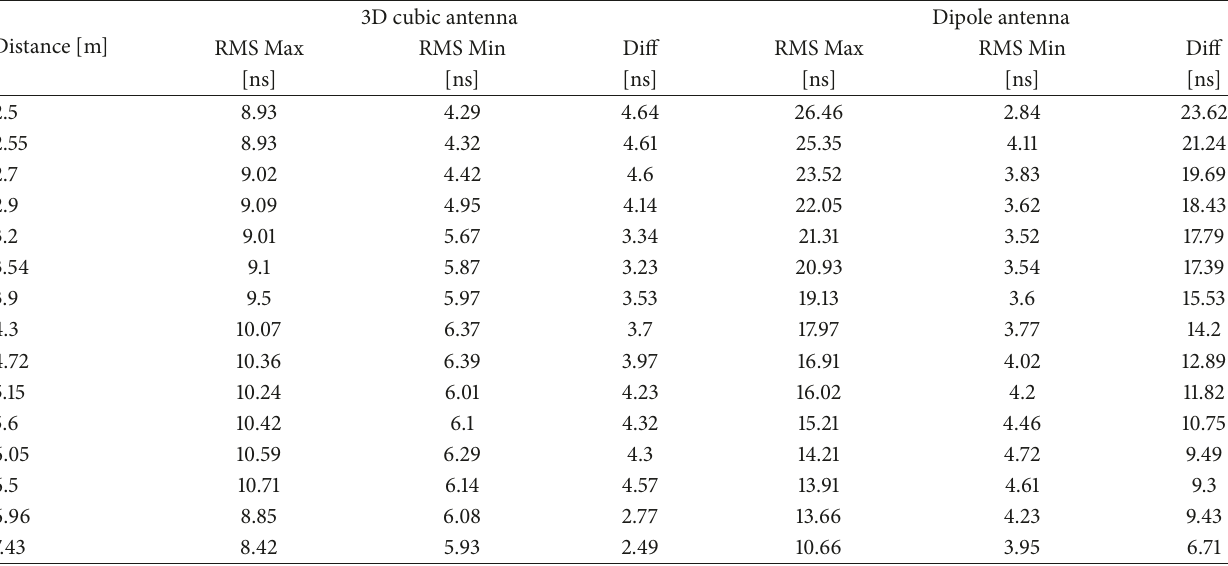
Table 6: Difference between RMS Max and Min in the NLOS